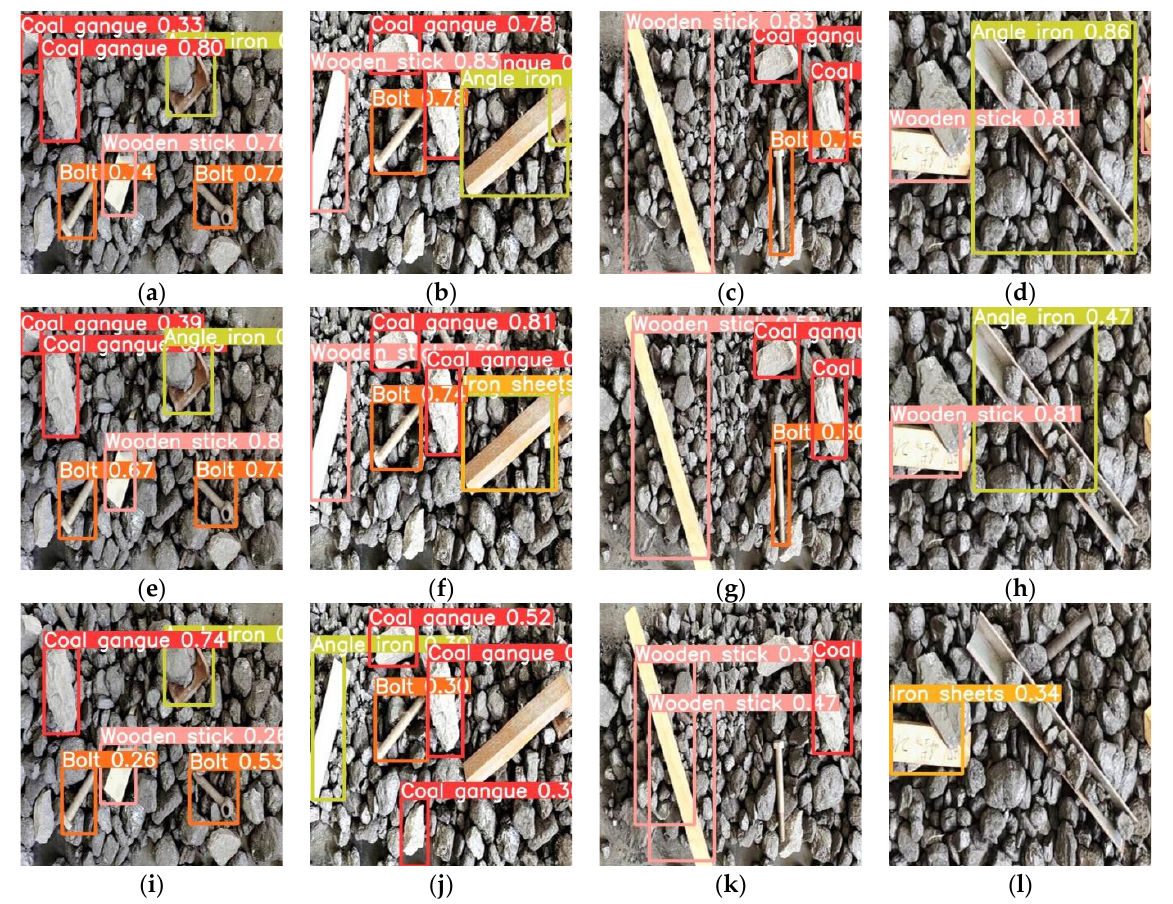
Figure 7. Detection results of the network before and after the improvement in test dataset, ( a – d ) be- long to the result achieved by the original Yolov5-s network, ( e – h ) are the detection results achieved by the improved network when the pruning rate is 0.8, and ( i – l ) are the detection results when the pruning rate is 0.9.